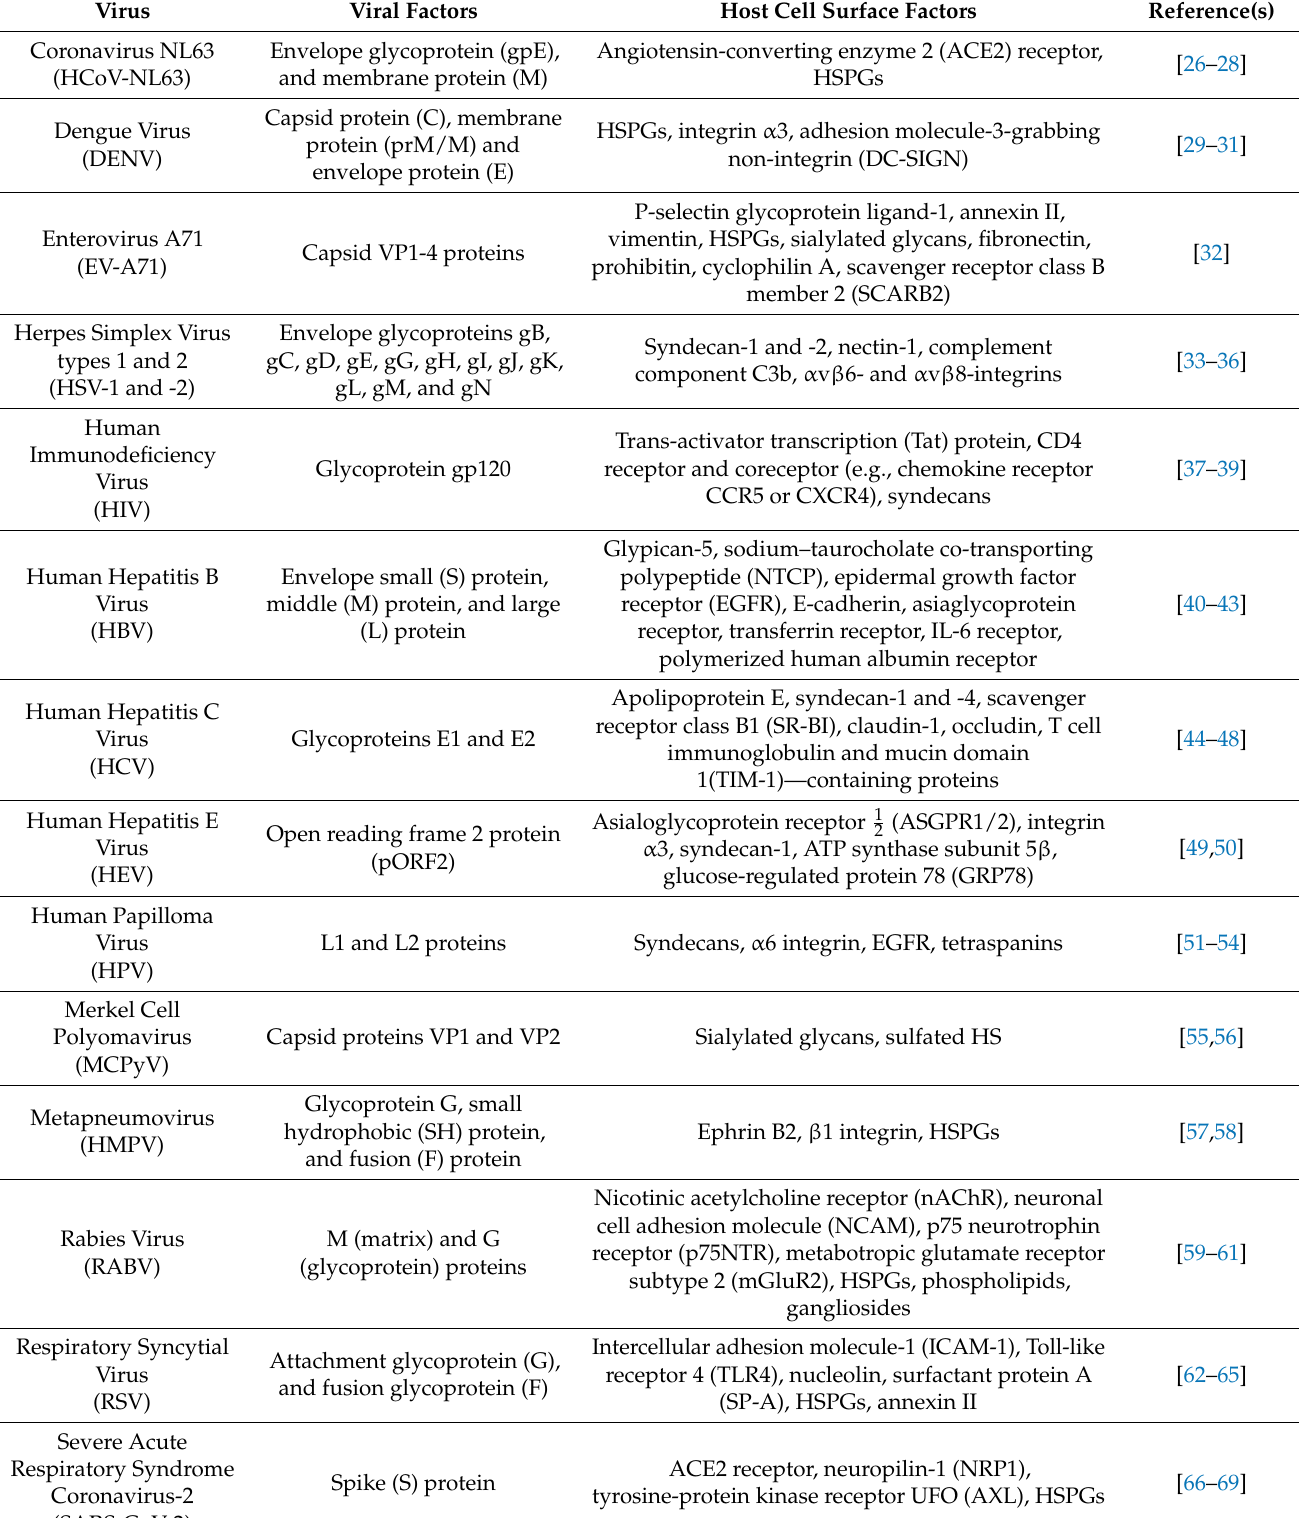
Table 1. Viral and host factors involved in the attachment and entry of human